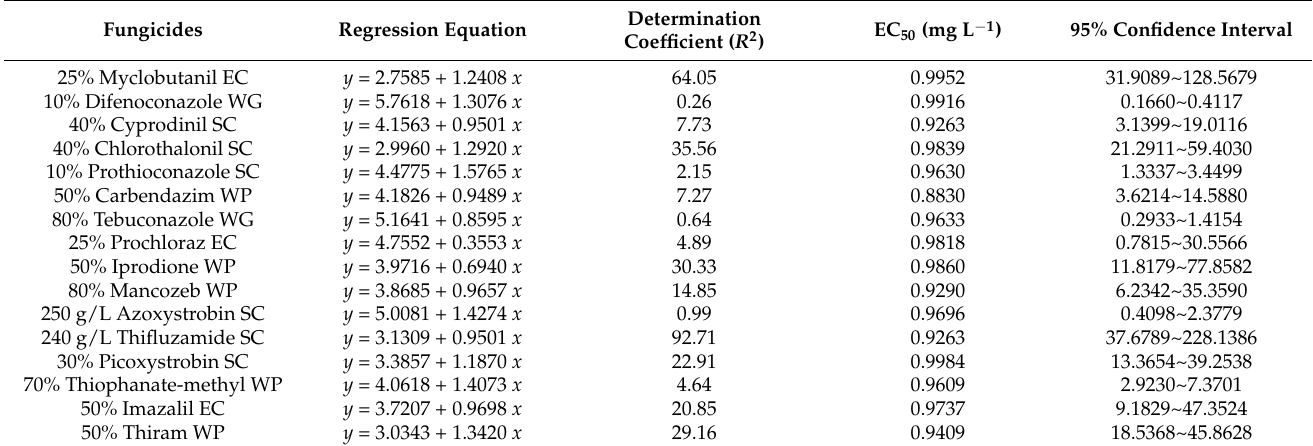
Table 4. The toxicities of sixteen fungicides to C . fructicola